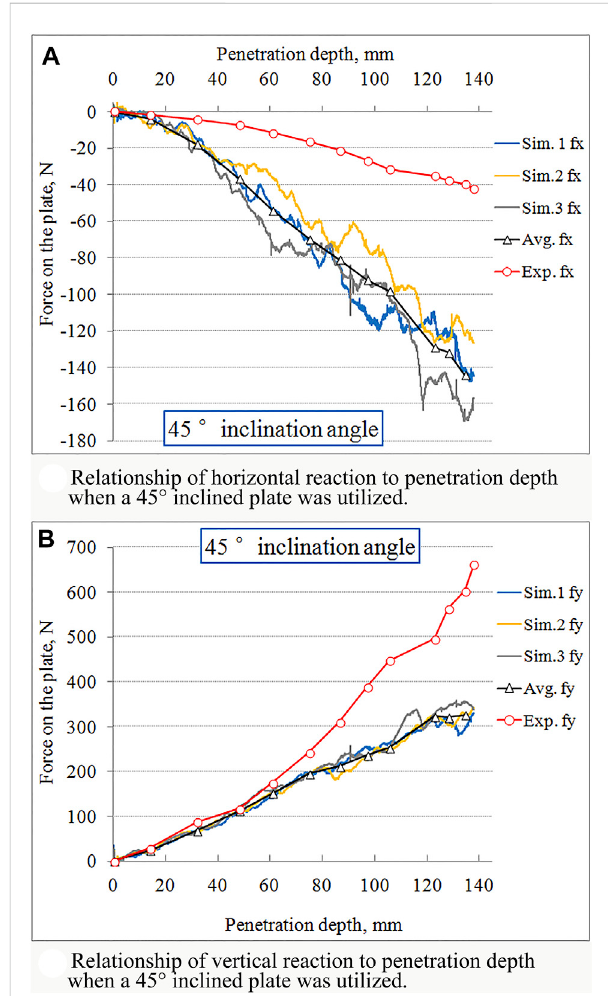
FIGURE 13 Reaction against penetration depth to a 30 ° inclined plate in cohesive soil. (A) Horizontal reaction against penetration depth to a 30 ° inclined plate in cohesive soil. (B) Vertical reaction against penetration depth to a 30 ° inclined plate in cohesive soil. FIGURE 14